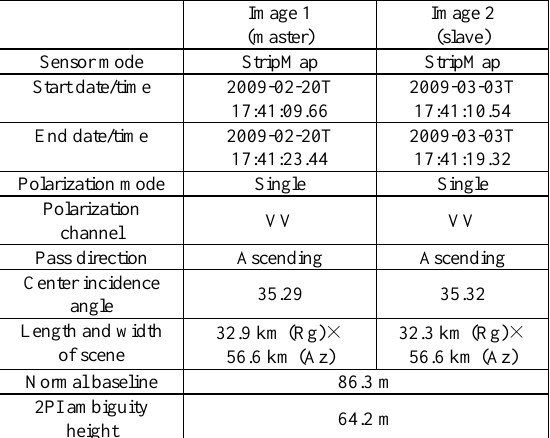
Table 1. Specification of TerraSAR images